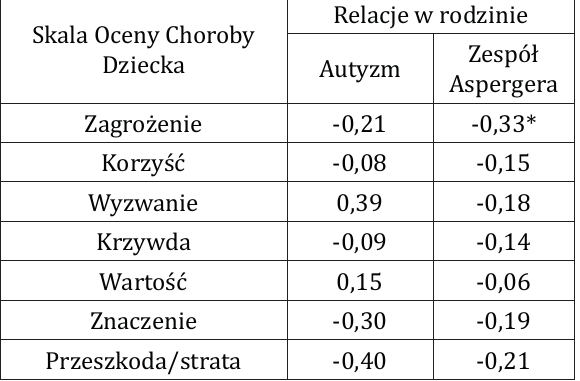
Tabela 1. Współczynniki korelacji obliczone między oceną relacji w rodzinie a wynikami w Skali Oceny Choroby Dziecka w grupie